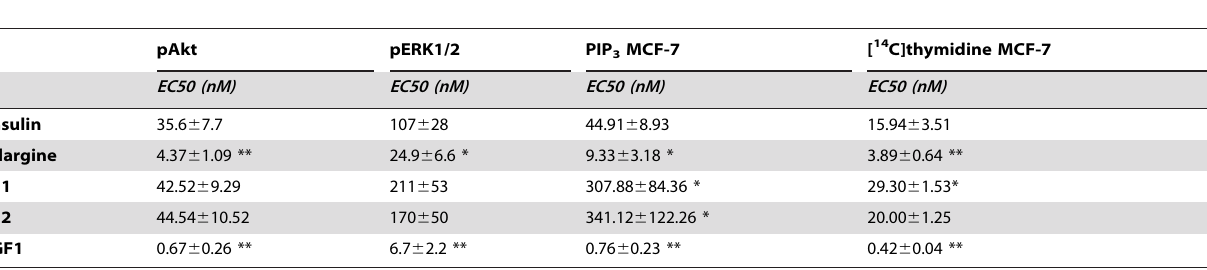
Table 4. EC50s of insulin, IGF1, glargine and glargine metabolites for PIP 3 production, Akt and Erk activation and thymidine incorporation in MCF-7 cells.